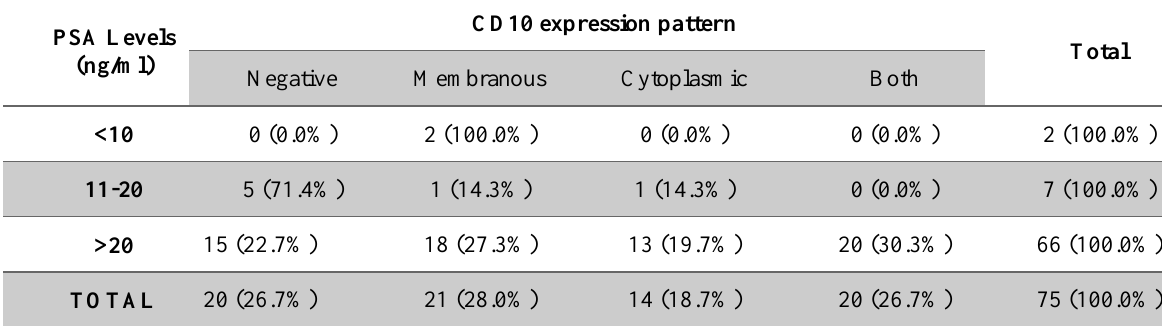
Table 4. Correlation between serum PSA levels and pattern of CD10 expression